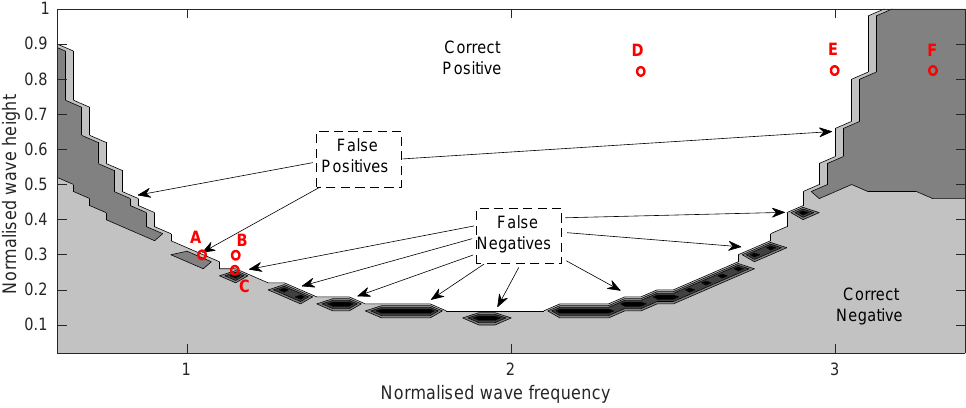
Figure 14. The performance of the early warning detection system in polychromatic waves; correct positives (white), correct negatives (grey), false positives (dark grey) and false negatives